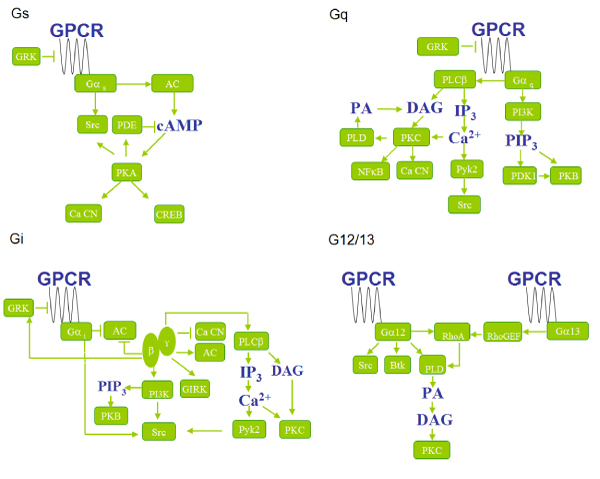
Major GPCR pathways, Gs, Gi/o, Gq/11, G12/13.